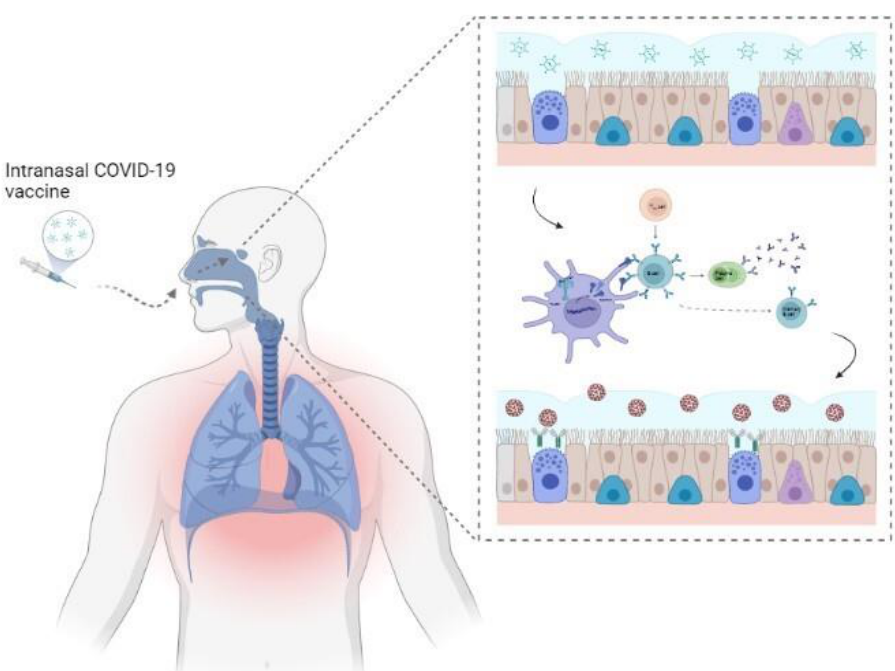
Figure 2. Principles of mucosal vaccination. Mucosal vaccine administration stimulates the synthesis of immunoglobulin A (IgA) at the level of mucosa-associated lymphoid tissue (MALT). The mucosal immune response is characterized at the local level by secretory IgA (SIgA) and cytotoxic T-cells, and at the systemic level by antigen-specific humoral and cellular responses. These outcomes have been shown to be effective in clearing various pathogens, including respiratory viruses.